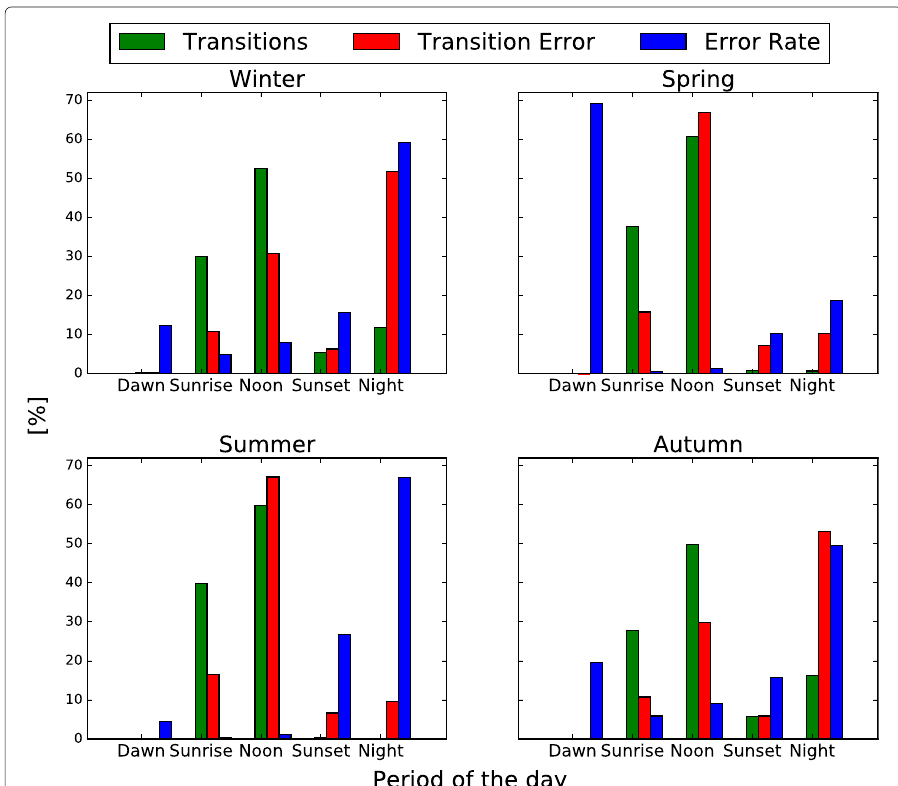
Fig. 5 Correlation between periods of the day, normalized transition and transition